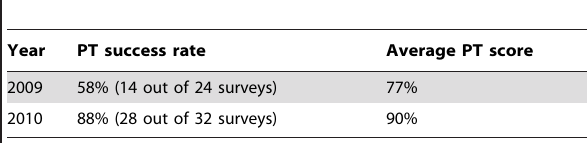
Table 4. PT Performance in 2009–2010 for all